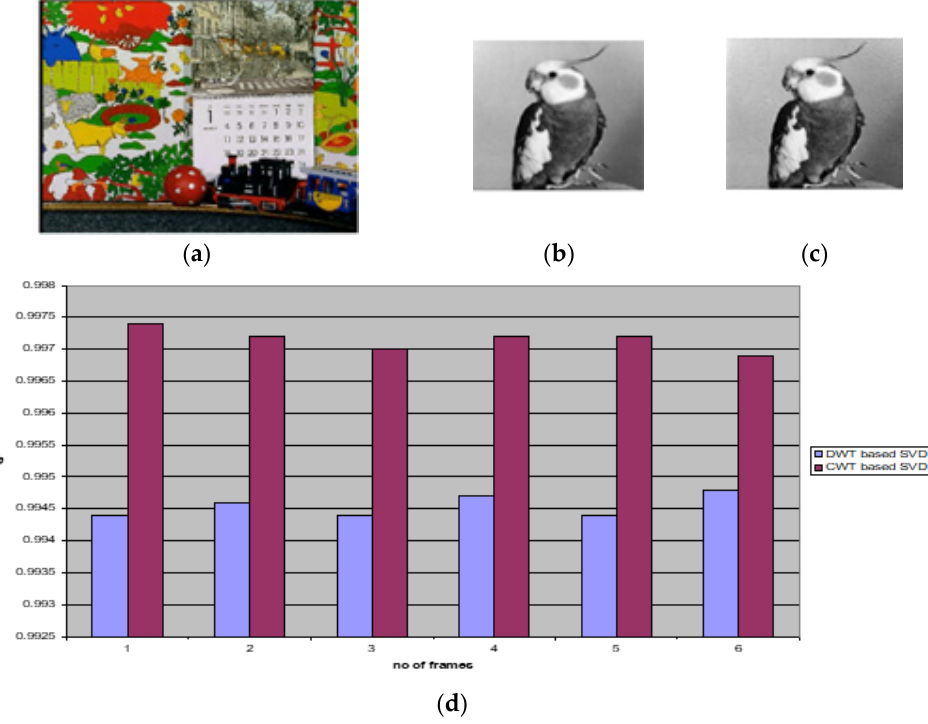
Figure 17. ( a ) The watermarked frame using the proposed method. ( b ) Extracted watermark from frame 10 of the first video scene in the proposed method. ( c ) Extracted watermark from frame 10 of the first video scene for the DWT-based SVD method. ( d ) Correlation values for the extracted watermarks from each six frames in the first video scene without attacks.